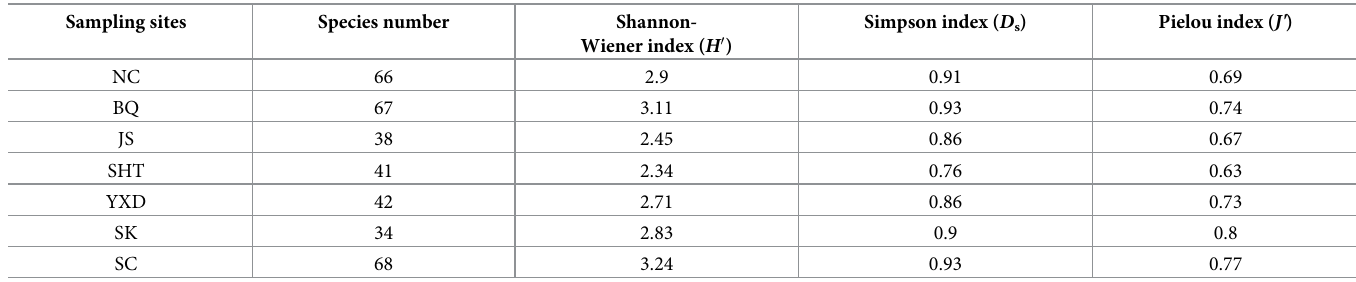
Table 1. Diversity index of fish assemblages among the seven sections in the middle and lower reaches of the Ganjiang River. Sampling sites Species